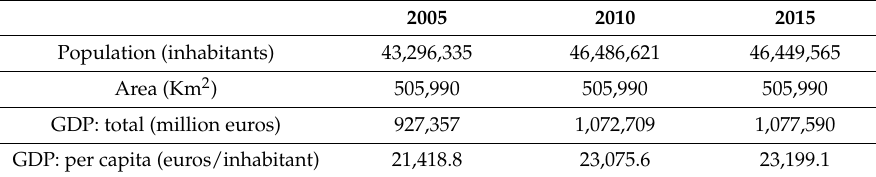
Figure 1. Map of Spain. (Available at: http://cmap.unavarra.es/rid=1QTS39HDW-1DQWXSC-1NG/España%20en%20Europa.gif). Table 1. Data for